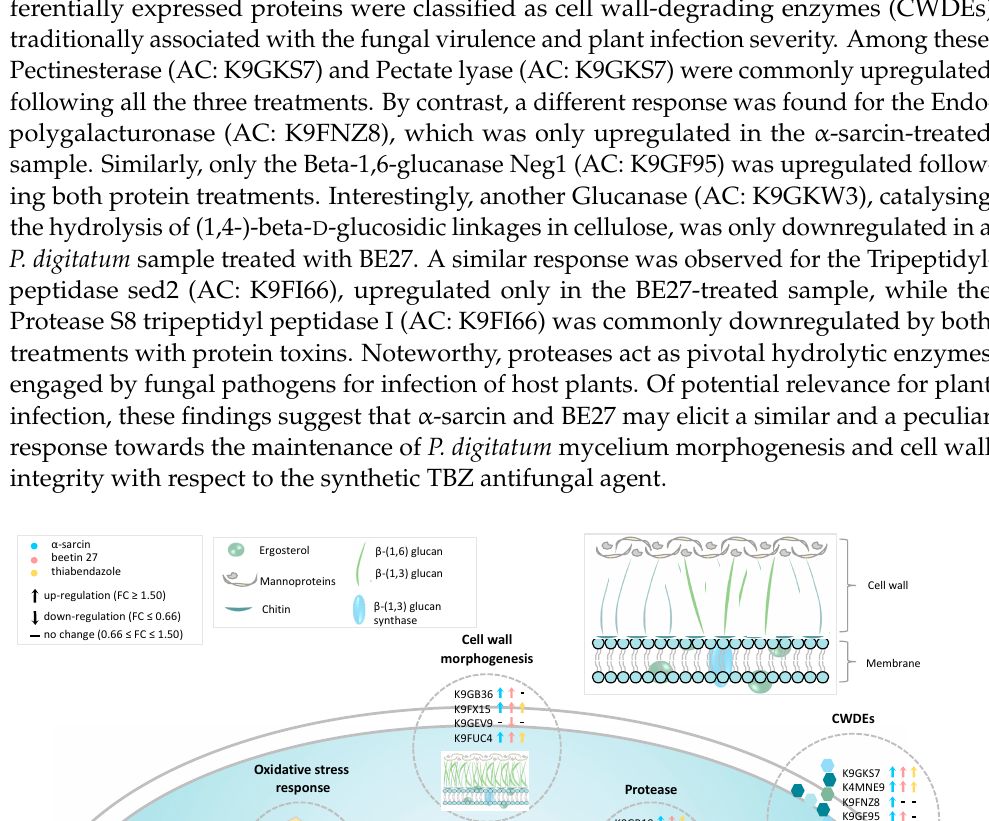
Figure 5. Overview of proteins modulated upon antifungal treatments. UniProt accession numbers and protein regulation levels are reported for each treatment (see arrow colours: light blue, α -sarcin; pink, beetin 27; yellow, thiabendazole).